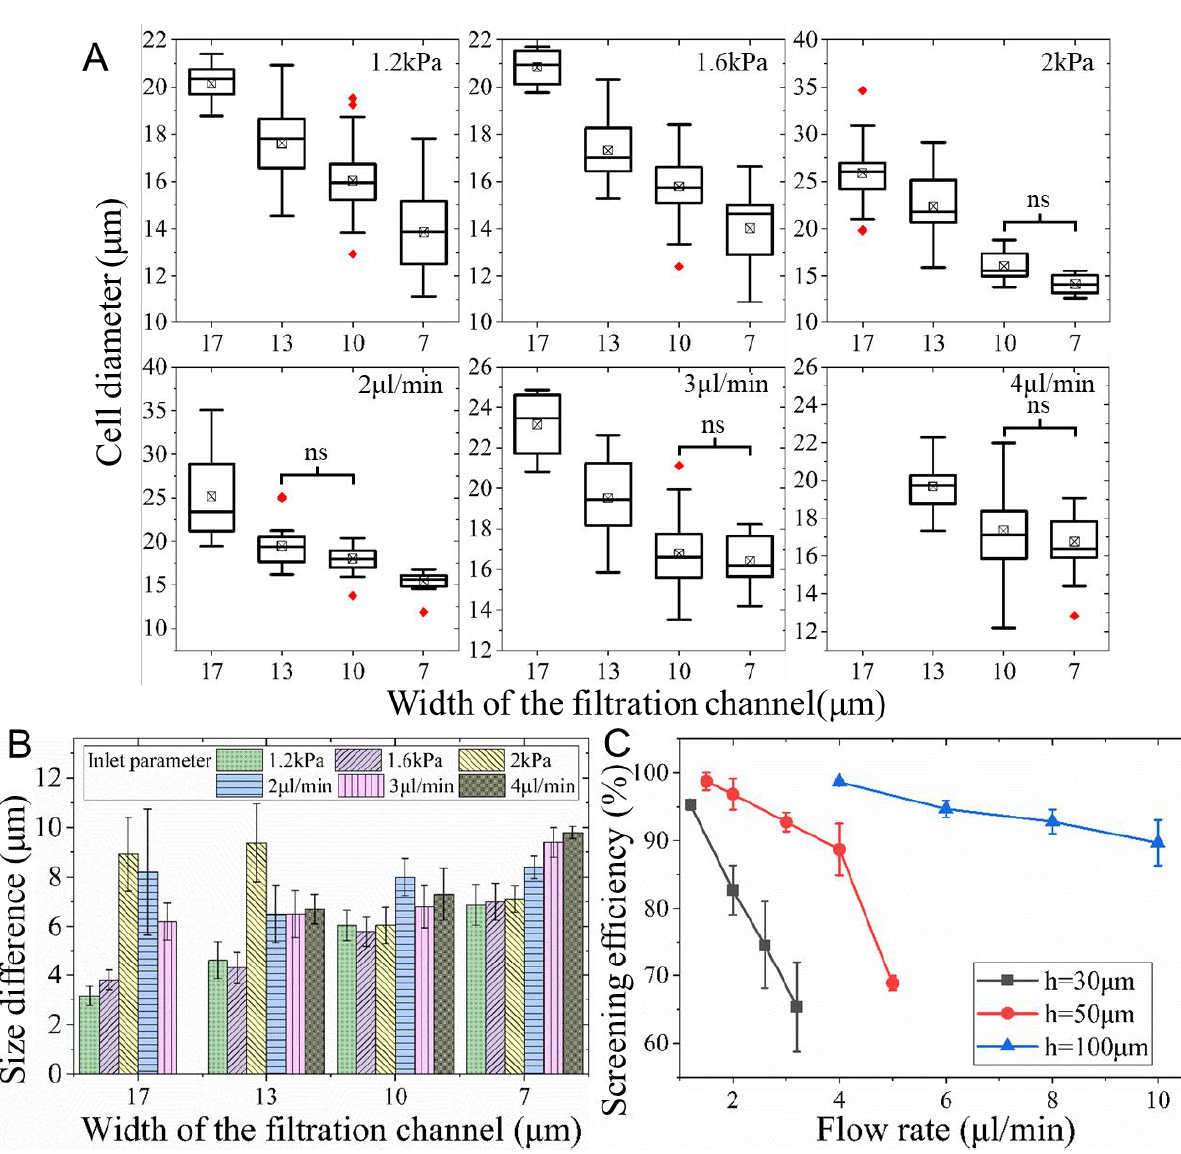
Figure 4. Size-based screening of K562 cells. ( A ) The size of cells (4 < N < 93) trapped by each filtration level and ( B ) the difference of cell size and filtration channel width when cell suspension was injected at various pressure or flow rate. ( C ) The separation efficiency of filtration channels with various heights (h) at distinct flow rates.